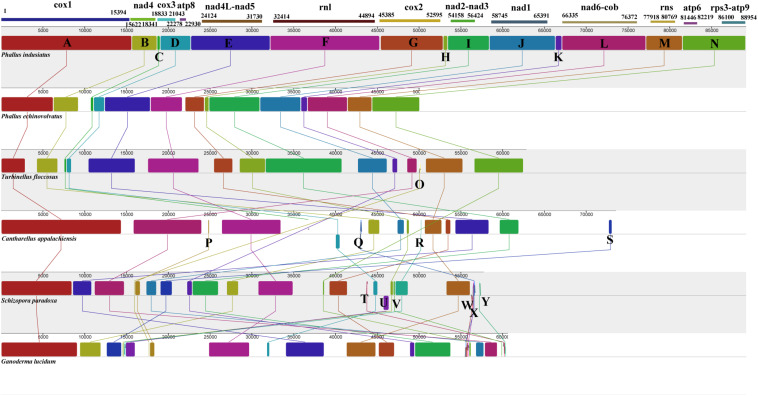
Mitogenome synteny among six Basidiomycetes species. Twenty-three homologs regions (A–Y) were identified among the six mitogenomes. The sizes and relative positions of the homologs fragments varied across the mitogenomes.